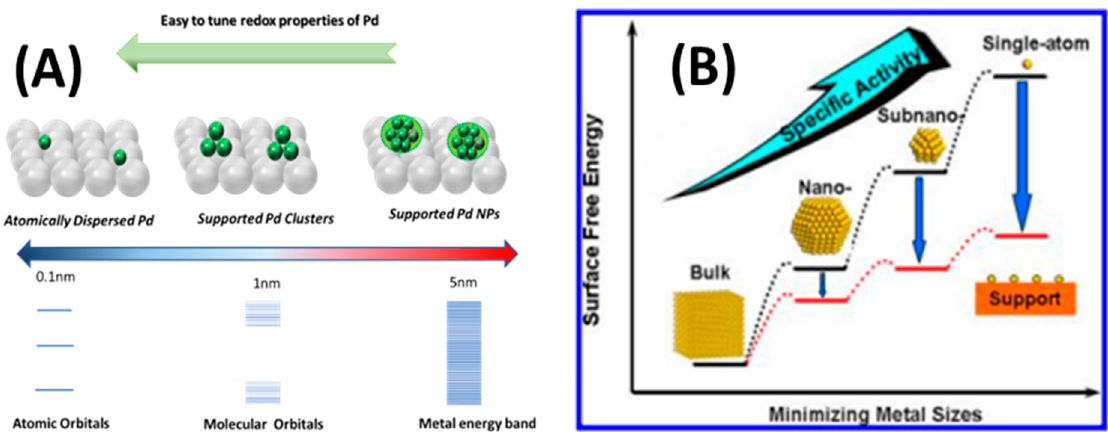
Figure 1. ( A ) Pd species with different size (single atom, clusters, and nanoparticles) supported on metal oxide matrix, and the electronic structure on different species is also presented ( B ); schematic illustration of the surface free energy vs . supported Pd species size.